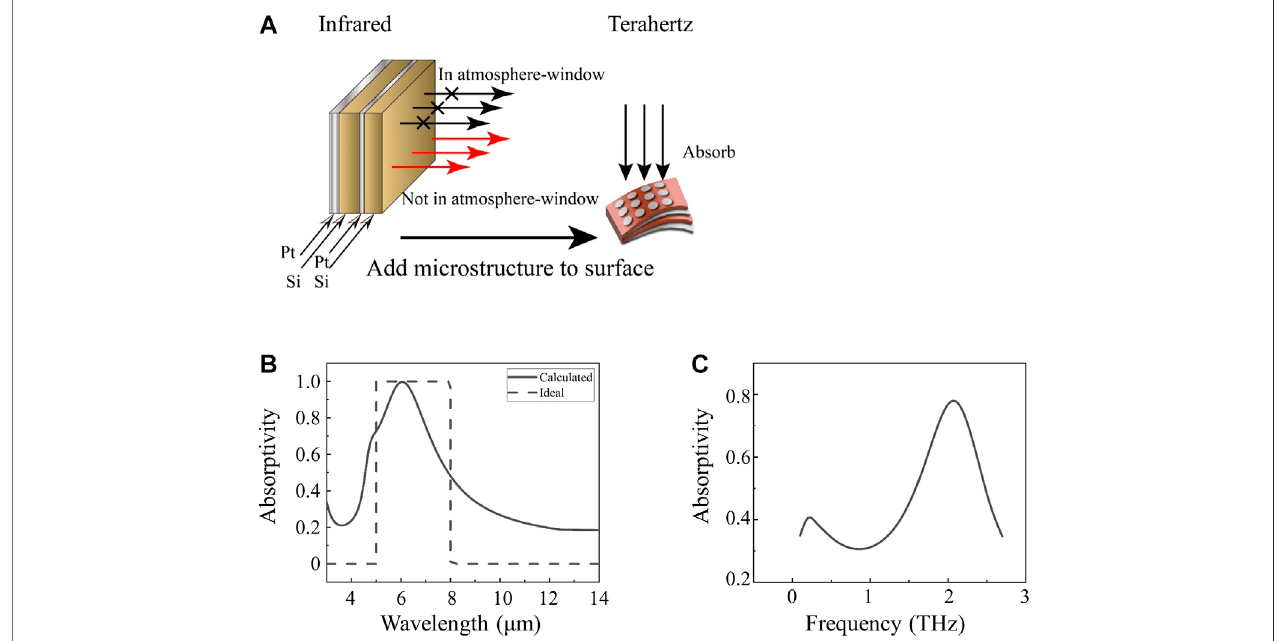
FIGURE2| Root-mean-square deviation(RMSD)oftheabsorptivity relative totheidealabsorberwiththicknesschanges. (A) inthetopSispacer; (B) inthemiddle Si space.